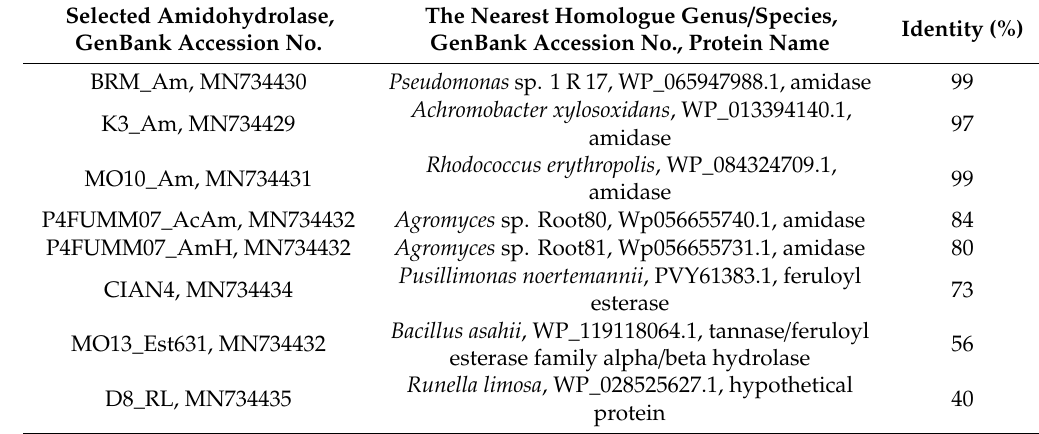
Table 1. The list of selected amidohydrolases and their nearest homologues. Selected Amidohydrolase, The Nearest Homologue Genus / GenBank Accession No.